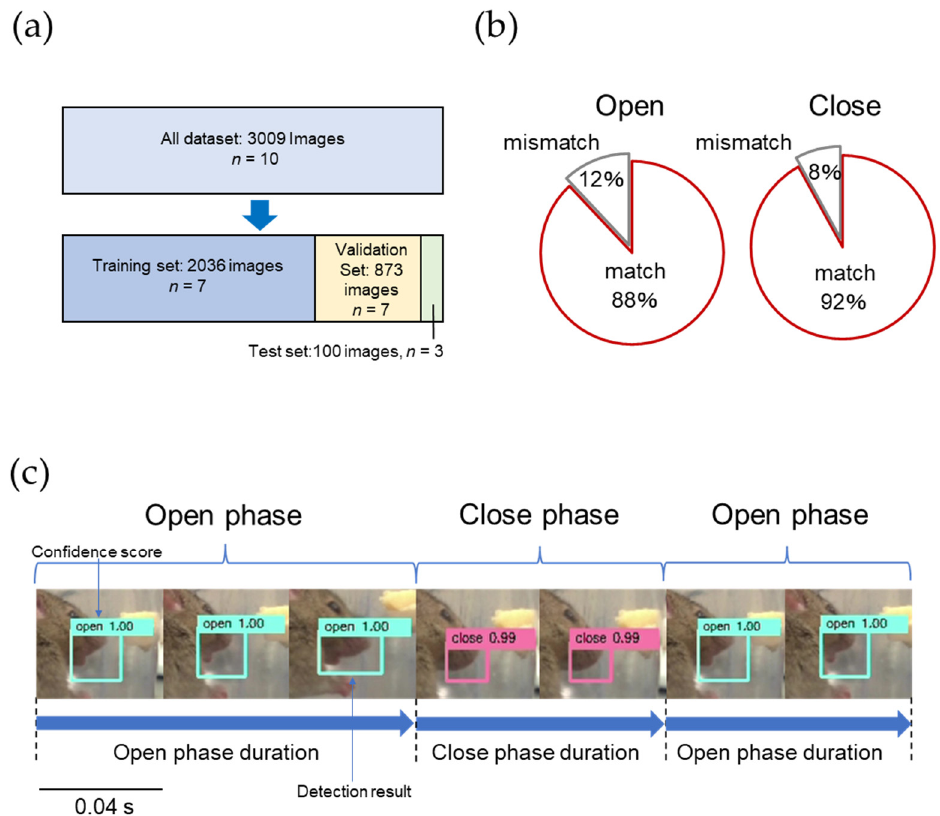
Figure 2. Detection of mouse opening and closing of the mouth. ( a ) Dataset used to develop the AI model for detecting mouth movements. ( b ) The percentage of agreement between the researchers and AI model in judging “open” and “close” mouth. ( c ) The measurement method of the open phase time and close phase time, 0.04 s × (the number of images judged as “open” or “close” consecutively), is open phase duration or close phase duration, respectively.